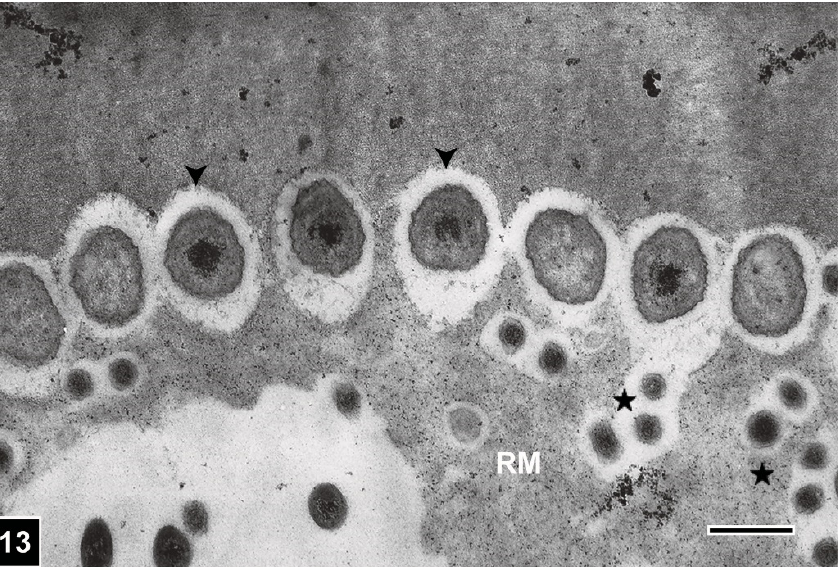
Figure 13. TEM of a transverse section through a Pinus radiata tracheid wall attacked by erosion bacteria, the primary degraders. The erosion bacteria display a near-circular profile and are present opposite crescent-shaped erosion troughs (arrowheads). The secondary degraders (scavenging bacteria) (asterisks) are associated with the residual material (RM). Scale bar = 2 µm. The image is reproduced from Singh et al. (2019) IAWA J.